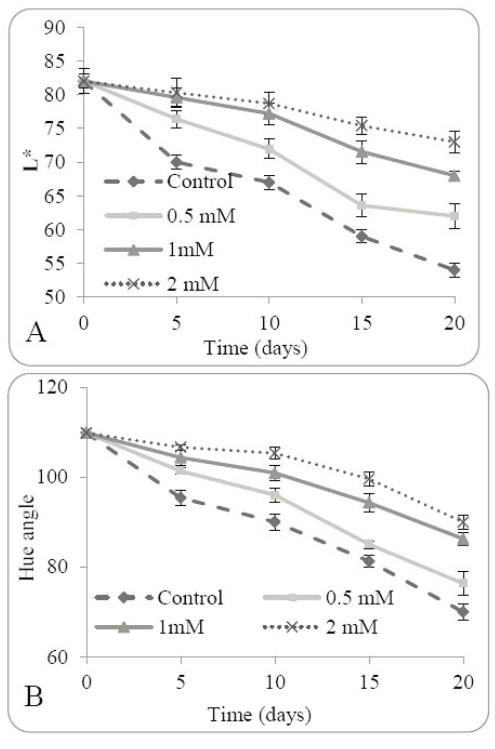
Fig. 2 - The effect of putrescine at different concentrations (0.5, 1 and 2 mM) on L* (A) and hue angle (B) of Musa acumi- nata L. during storage.